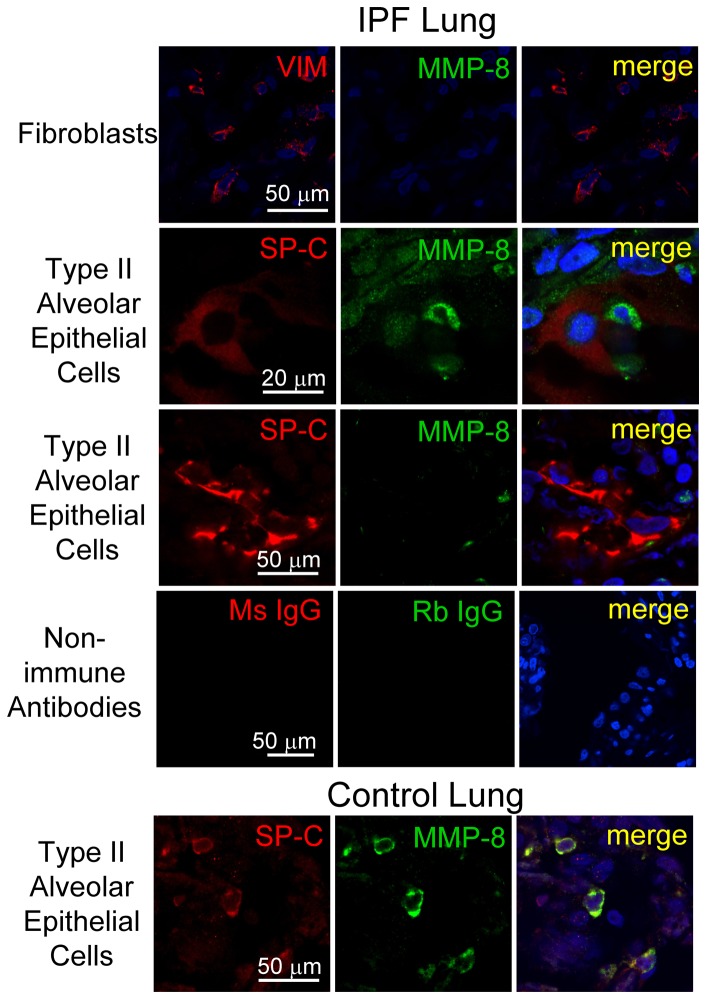
MMP-8 is not expressed in type II alveolar epithelial cells or fibroblasts in IPF lungs.Lung tissue was obtained from IPF patients undergoing lung transplantation (upper panel) or from rejected transplant donor lungs as a control (lower panel). Formalin-fixed lung sections were stained with a red fluorophore (left column) for fibroblasts (vimentin; VIM) or type II alveolar epithelial cells (surfactant protein C, SPC) and a green fluorophore for MMP-8 (middle column). Other lung sections were stained with isotype-matched non-immune murine IgG (Ms IgG) or rabbit IgG (Rb IgG). Nuclei were stained with DAPI and lung sections examined using a confocal microscope. Merged images (right column) show no staining for MMP-8 in cells identified as fibroblasts or type II alveolar epithelial (ATII) cells in an area of severe fibrosis in the IPF lung. Control lung sections show positive staining for MMP-8 in type II alveolar epithelial cells (lower panels). Magnification is X 600.